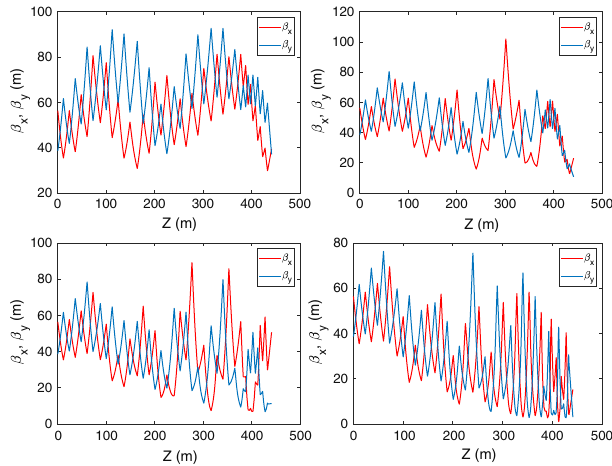
FIG. 5. The β functions of the four electron bunches with typical energies of 8.74 (top left), 5.11 (top right), 3.30 (bottom left), and 1.48 GeV (bottom right), respectively, along the L4 and the dechirper section based on the optimized